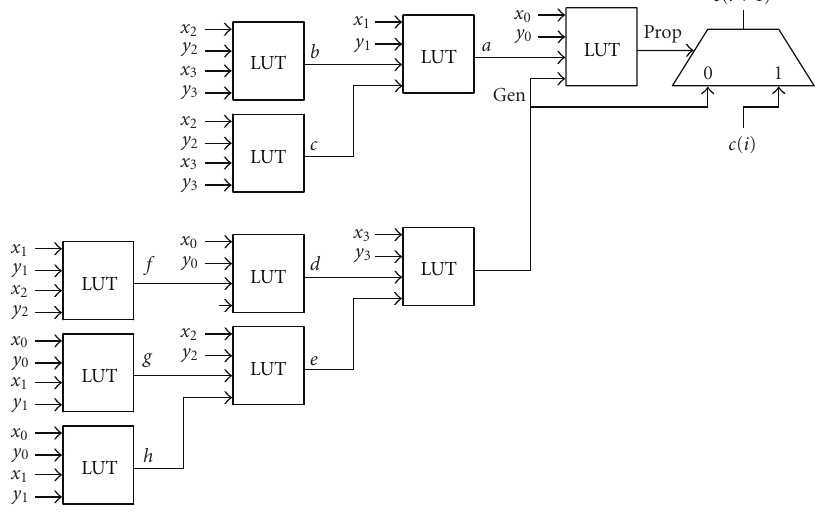
Figure 11: Carry generation ( GP b architecture).